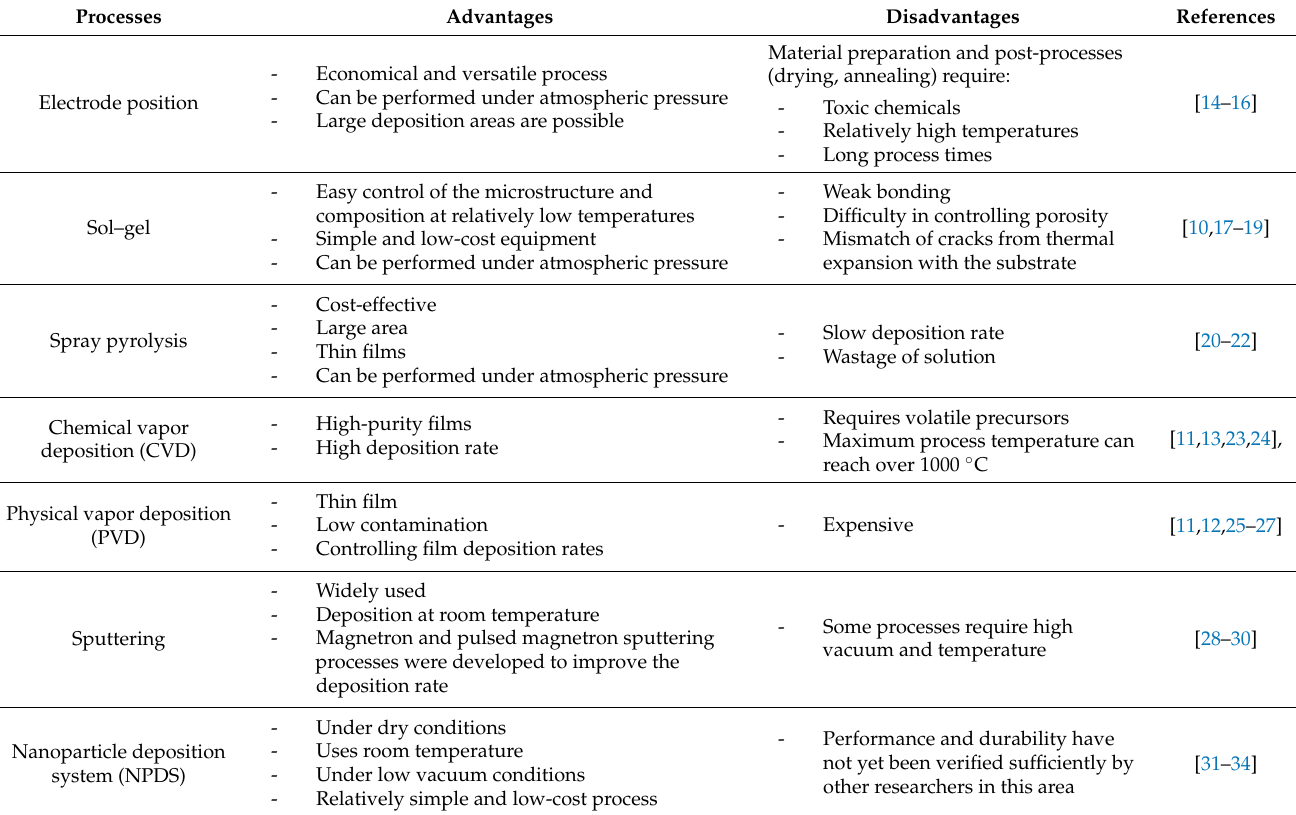
Table 1. Advantages and disadvantages of fabrication processes for electrochromic